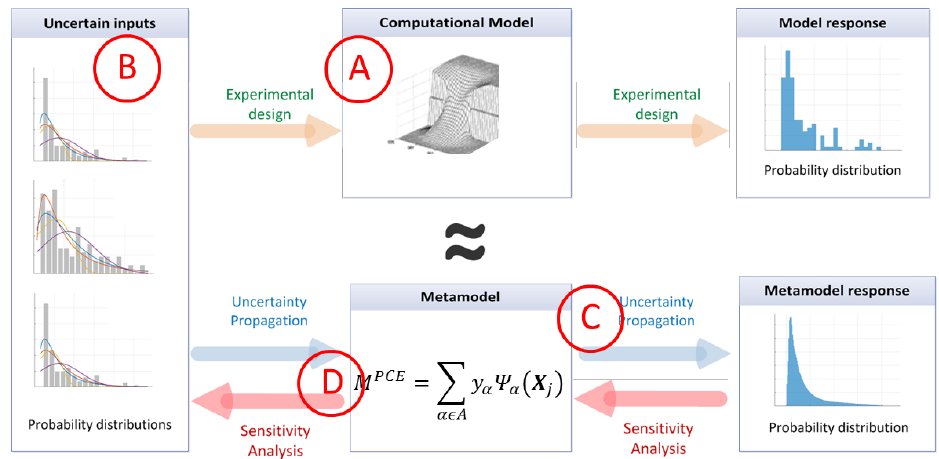
Figure 1. Framework for uncertainty quantification: Step A—computational model; Step B—model input uncertainty description; Step C—uncertainty propagation; Step D—sensitivity analysis of the model output.